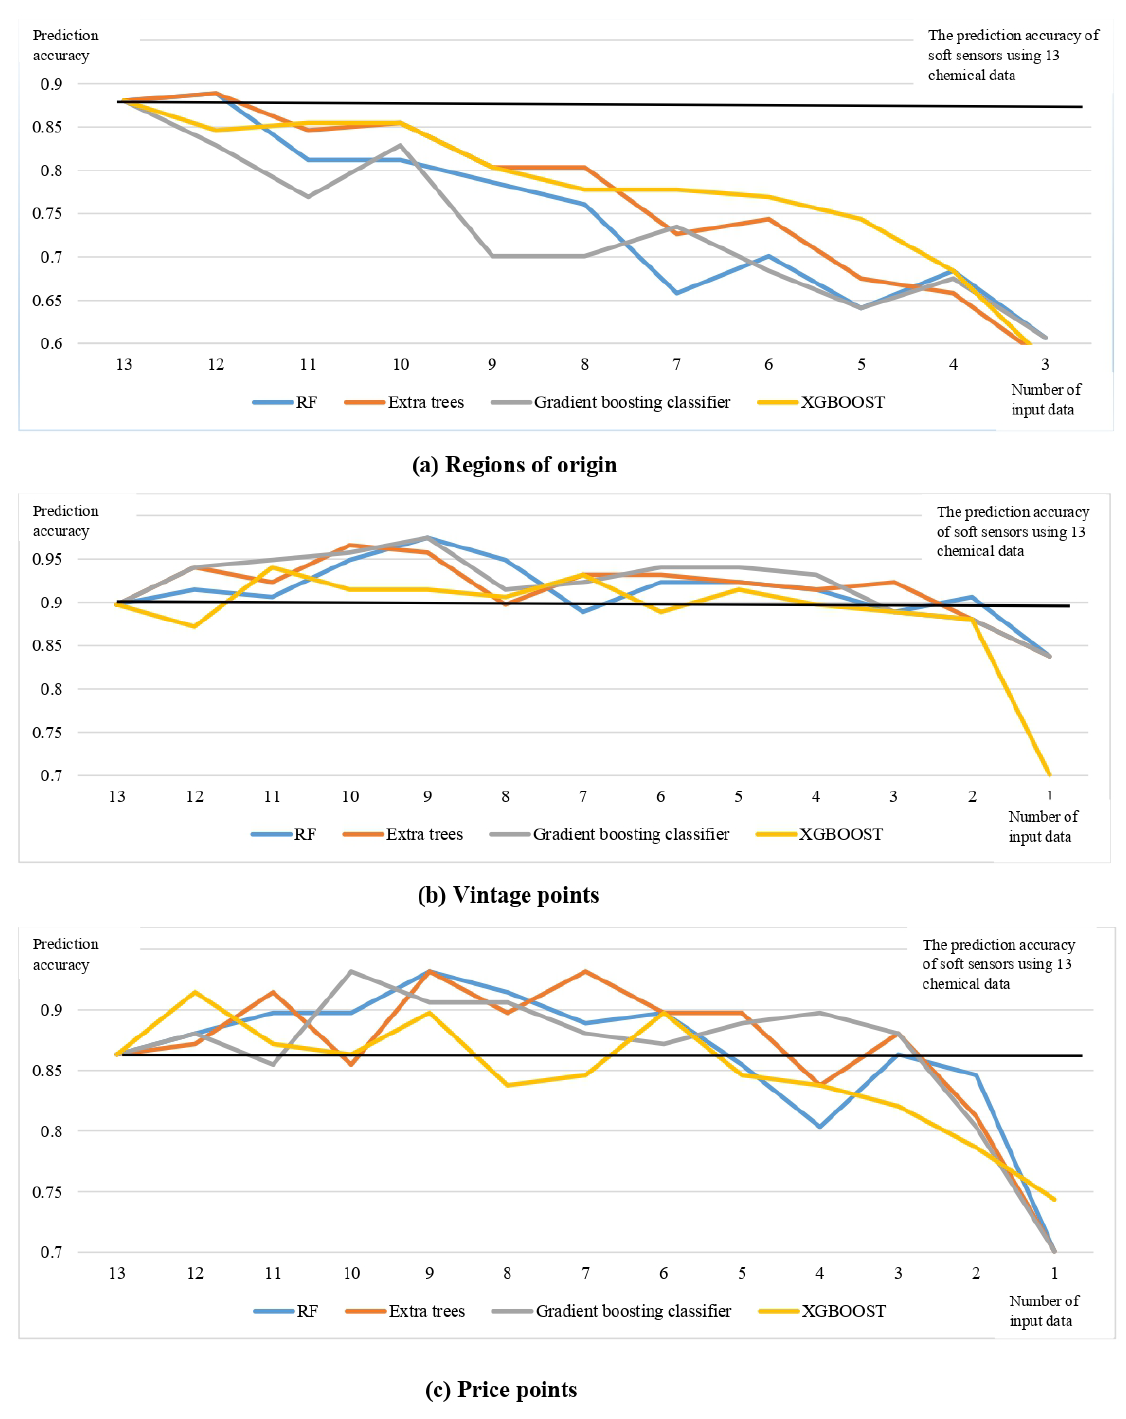
Figure 7. Prediction accuracy of soft sensors to predict regions of origin, vintage points, and price points with different input data. ( a – c ) display the prediction accuracies for soft sensors to predict New Zealand Pinot Noir wines’ regions of origin, vintage points and price points with different numbers of input data respectively. These input data were reduced with the help of the feature selection method Random Forest (RF), Extra trees classifier, Gradient boosting classifier and Extreme gradient boost (XGBOOST),